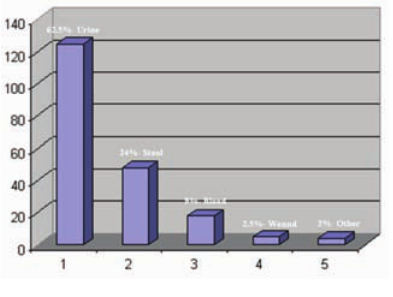
Figure 1. The frequency and source of E. coli isolates collected from Tehran hospi- tals during 6 months.